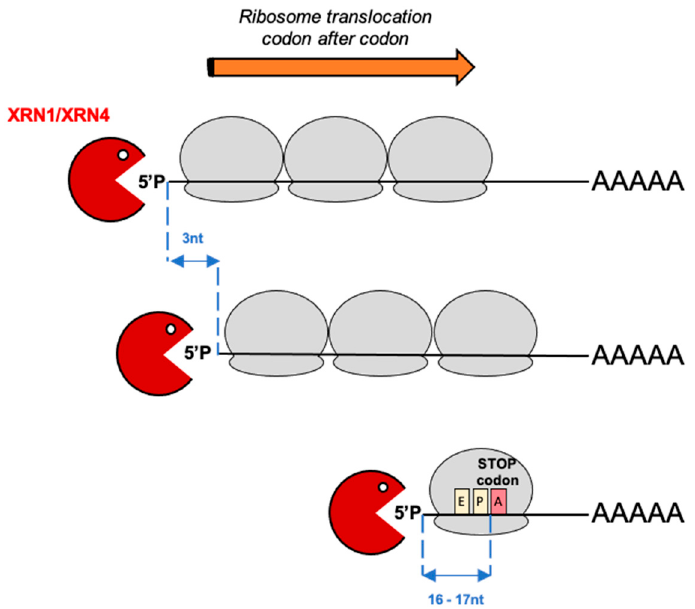
Figure 1. Representation of the co-translational mRNA decay pathway. The co-translational mRNA decay pathway was discovered in many organisms such as yeast, mammals or plants. For this process, decapping occurs on polysomes generating a 5 ′ monophosphate (5 ′ P) extremity. The exoribonuclease XRN1/XRN4 immediately follows the last ribosome codon after codon and degrades the mRNA as it is being translated. A 3 nucleotide periodicity is thus observed between 5 ′ P reads. As the termination step is slower than elongation, a general 5 ʹ P reads accumulation can be revealed 16–17 nucleotides upstream of stop codons. This distance corresponds exactly to a ribosome stalled at the A site.